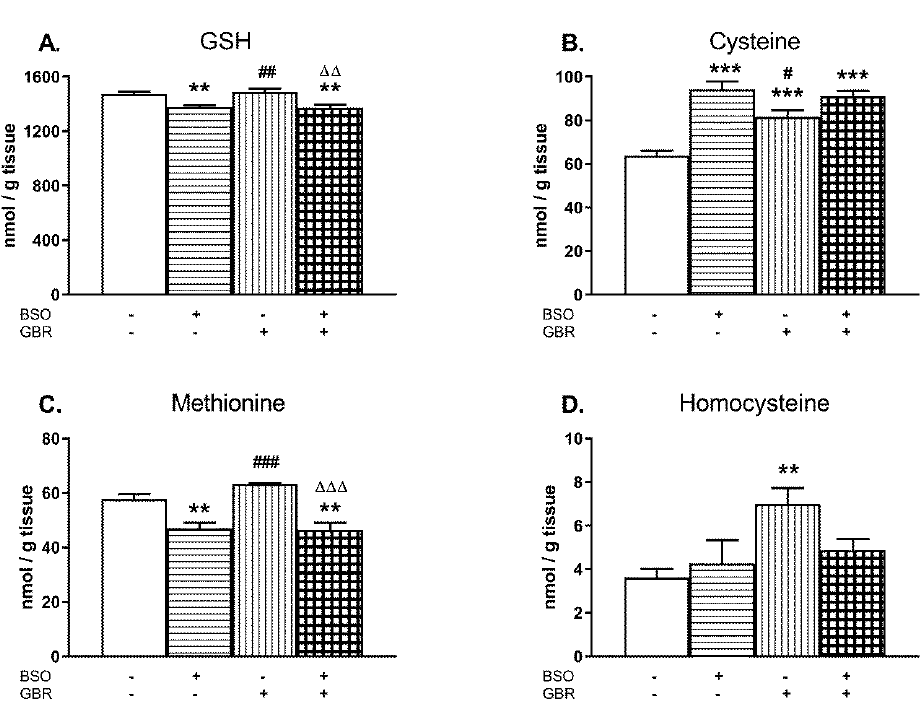
Figure 3. The effects of chronic administration of BSO and GBR 12909, alone and in combination, on the levels of GSH ( A ), Cys ( B ), Met ( C ), and Hcy ( D ) in the prefrontal cortex (PFC) of 16-day-old rats. Data expressed in nmole/g of tissue are presented as the mean ± SEM, n = 8 for each group. Statistical analysis was performed using a two-way ANOVA; symbols indicate significance of differences according to the Newman–Keuls post-hoc test, ** p < 0.01, *** p < 0.001, vs. control; # p < 0.05, ## p < 0.01, ### p < 0.001 vs. BSO- and ∆∆ p < 0.01, ∆∆∆ p < 0.001 vs. GBR 12909-treated groups.